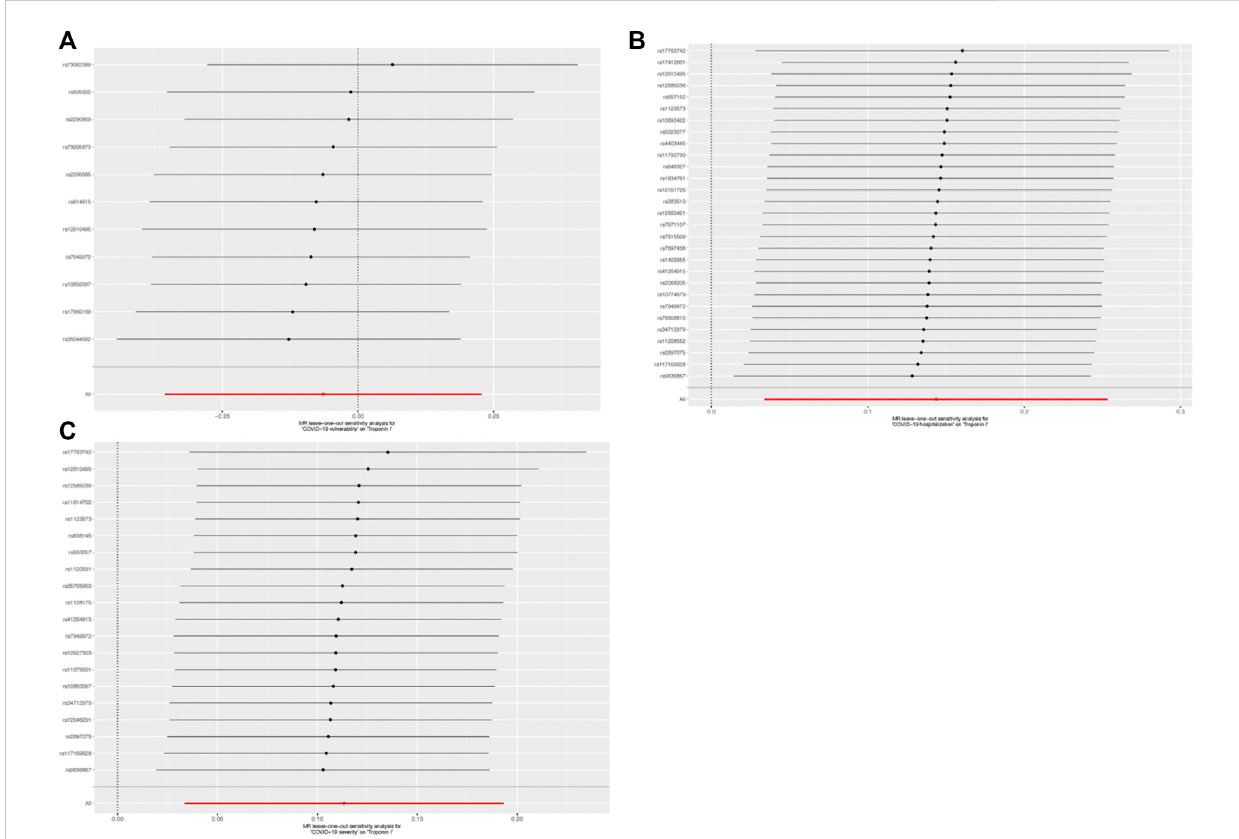
FIGURE 6 Leave-one-out outcome for single-nucleotide polymorphisms (SNPs) concerning COVID-19 and cardiac injury. (A) Leave-one-out outcome for SNPs concerning COVID-19 vulnerability and cardiac injury risk; (B) Leave-one-out outcome for SNPs concerning COVID-19 severity (hospitalization) and cardiac injury risk; and (C) Leave-one-out outcome for SNPs concerning the severity of COVID-19 (severe respiratory symptoms) and cardiac injury